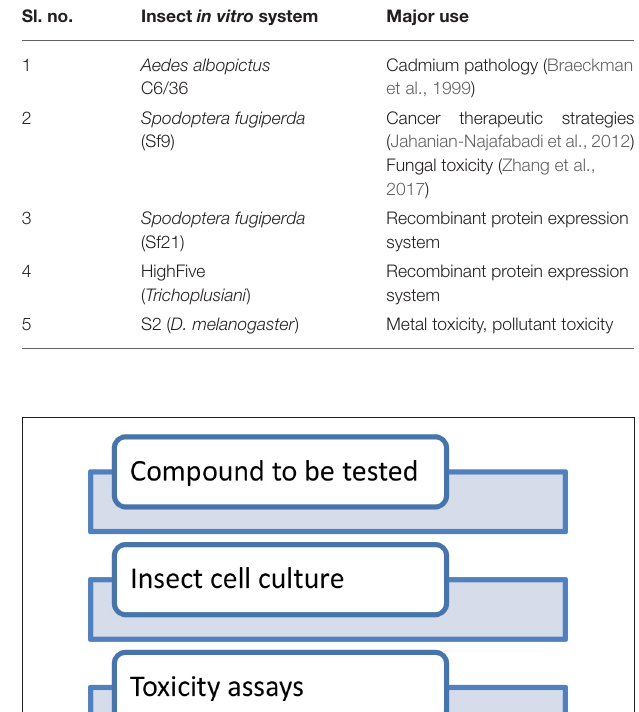
TABLE 1 | Examples for well-established insect cell lines. Sl. no.